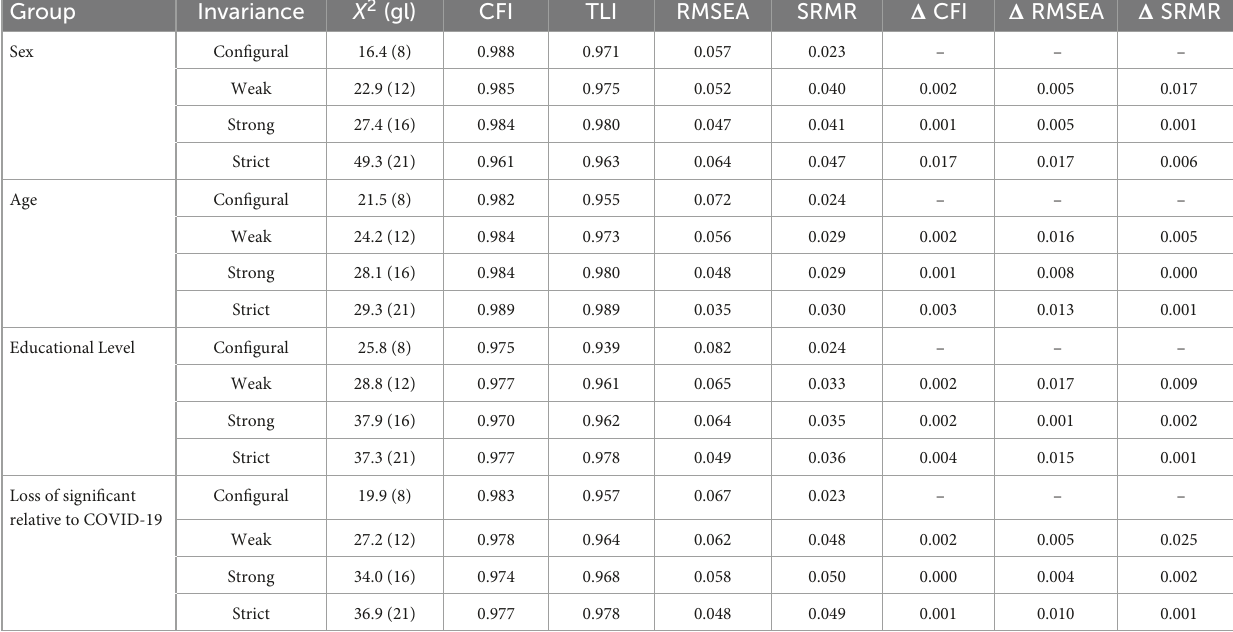
TABLE 4 Measurement invariance of the Coronavirus Reassurance Seeking Behavior Scale across groups.